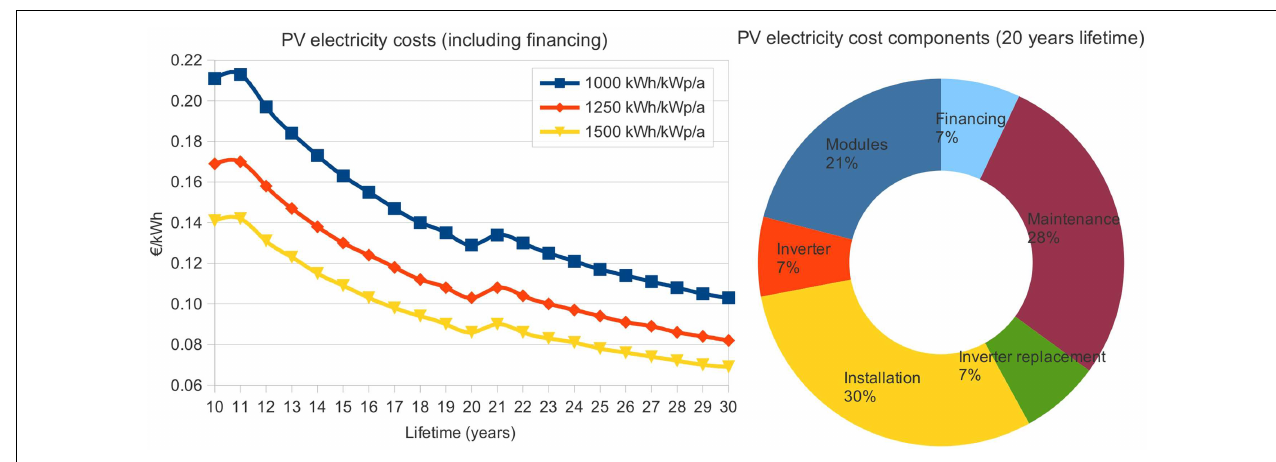
FIGURE 4 | PV costs including financing as function of lifetime and cost composition for three hypothetical sites